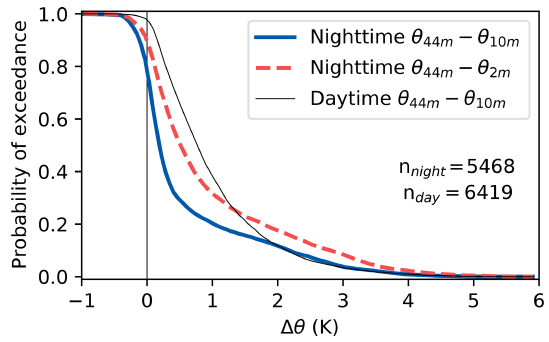
Figure 8. Cumulative probability distribution of the difference in temperature between the forest interior and the air above the forest (at 44m). Thick solid line shows the nighttime distribution for 10m; dashed line shows the nighttime difference for 2m; thin line shows the daytime difference at 10m. Positive numbers denote a colder forest